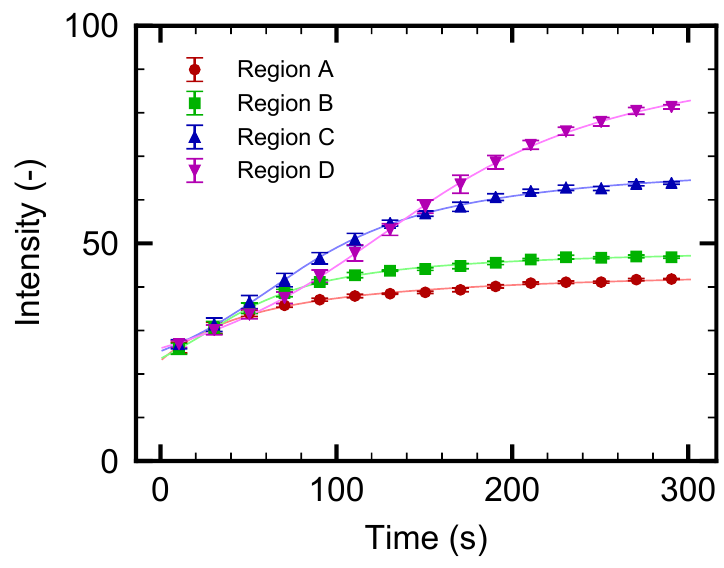
Figure 6. Time-development for fluorescence intensity of nanoparticles in the regions A, B, C, and D indicated in Figure 5a. The pressure difference ∆ P is set to 1.0